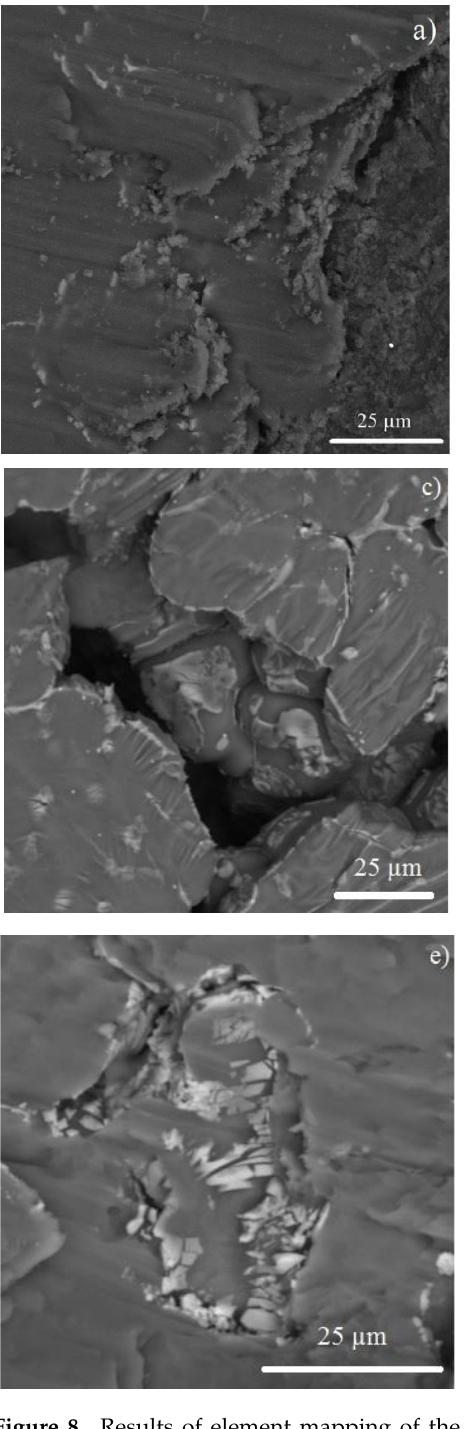
Figure 8. Results of element mapping of the fracture surface of magnesium alloys Mg–Ca–Zn reference ( a , b ), Mg–Ca–Zn–ND ( c , d ) and Mg–Ca–Zn US ( e , f